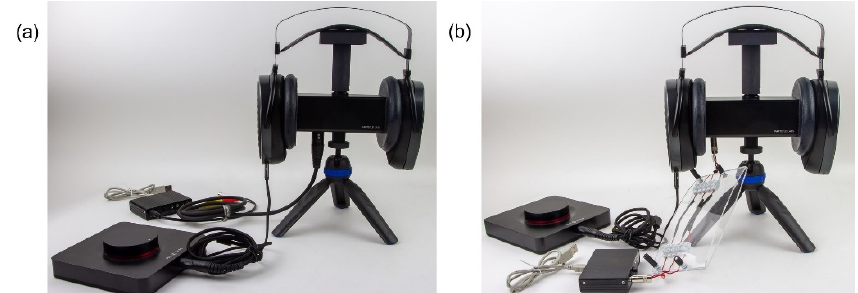
Figure 7. ( a ) Control setup for frequency response measurement of the HiFiMAN Arya headphones using commercial copper headphone and microphone cables and ( b ) the setup using the CNT/Cu audio cable as the microphone cable along with the same commercial headphone cable from before.